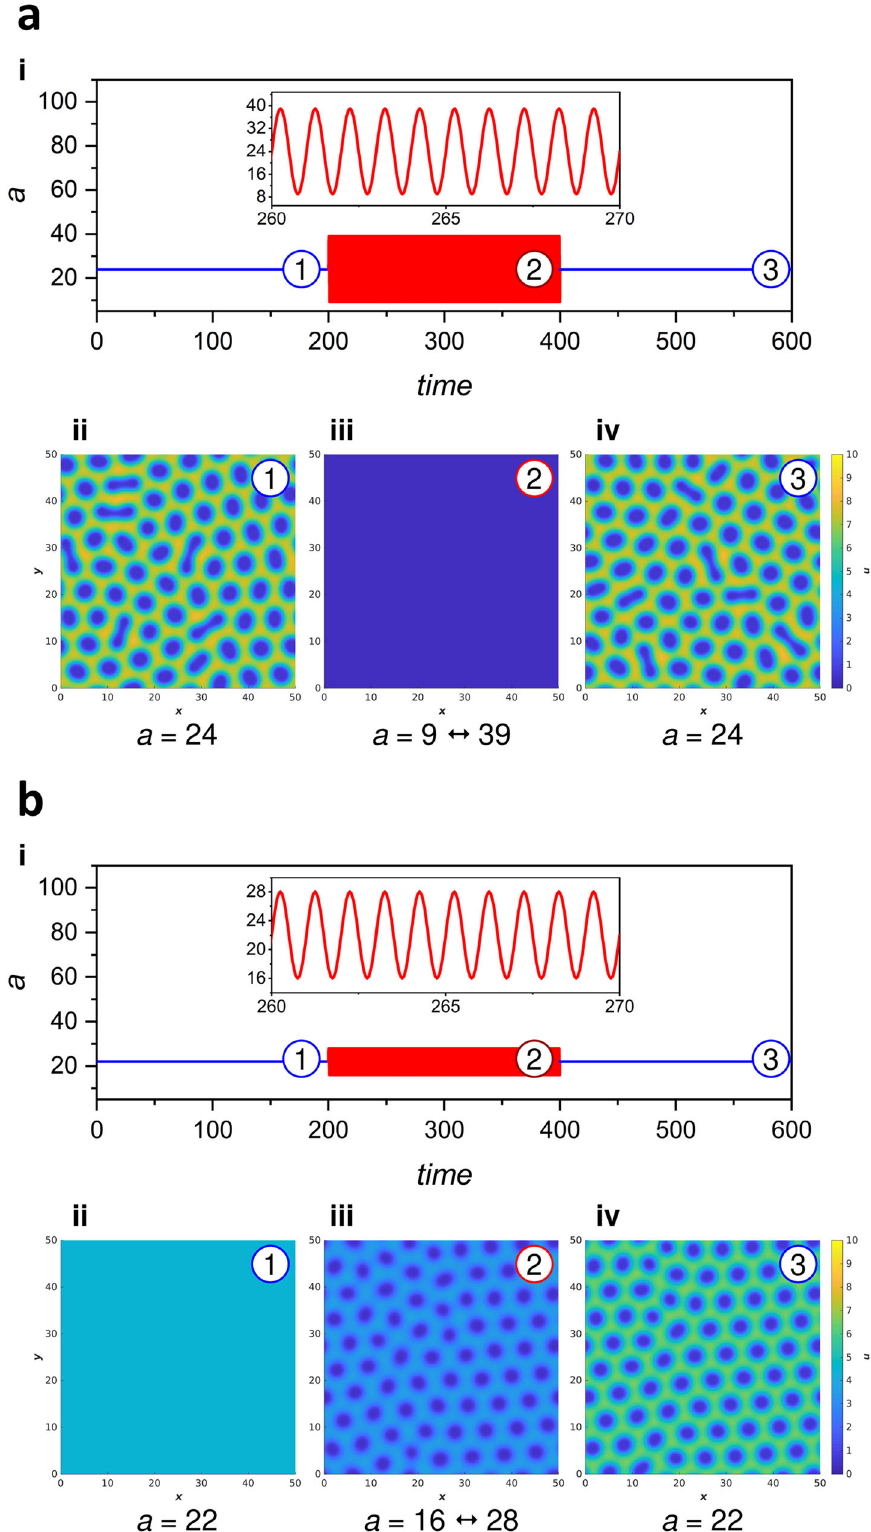
Fig. 3 Periodic forcing of the feed concentration a in numerical simulations. Disappearance of stationary Turing spots induced by the periodic forcing of the feed concentration a . The initial a = 24 was modulated with an amplitude of 15 and a time period of 1 ( a ). The appearance and locking of stationary Turing spots induced by the periodic forcing of the feed concentration a . The initial a = 22 was modulated with an amplitude of 6 and a time period of 1 ( b ). In fi gures a and b : (i) change of the feed concentration a during the whole simulation. (ii) – (iv) Snapshots of the pattern generated with constant a before the forcing (1), periodic forcing of a (2), and constant a after the forcing (3). The following parameter set was used: σ = 8, b = 1.9, c = 1.5, 4 x ¼ 4 y ¼ 1 : 25 ´ 10 (cid:2) 1 (grid spacing), and 4 t ¼ 3 : 124 ´ 10 (cid:2) 4 (time step). The length of the simulation domain and the simulation time were 50×50 and 600, respectively. All parameters are